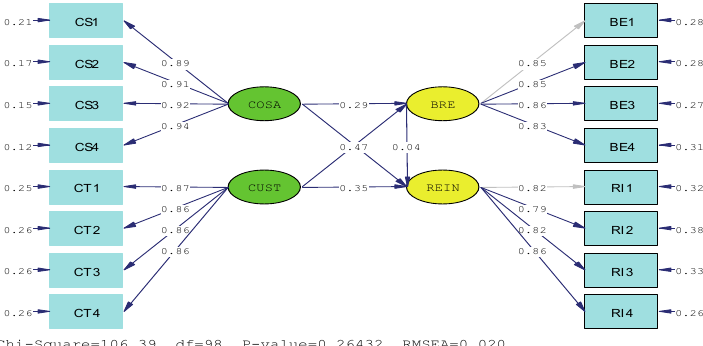
Fig. 2 . Path diagram of structural model without interaction (standardized